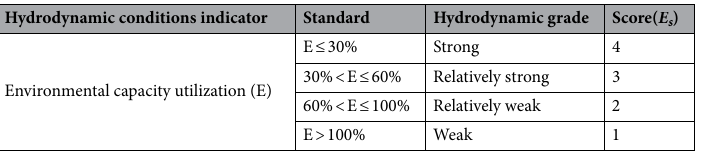
Table 2. Evaluation indicator and criteria of marine hydrodynamic conditions.